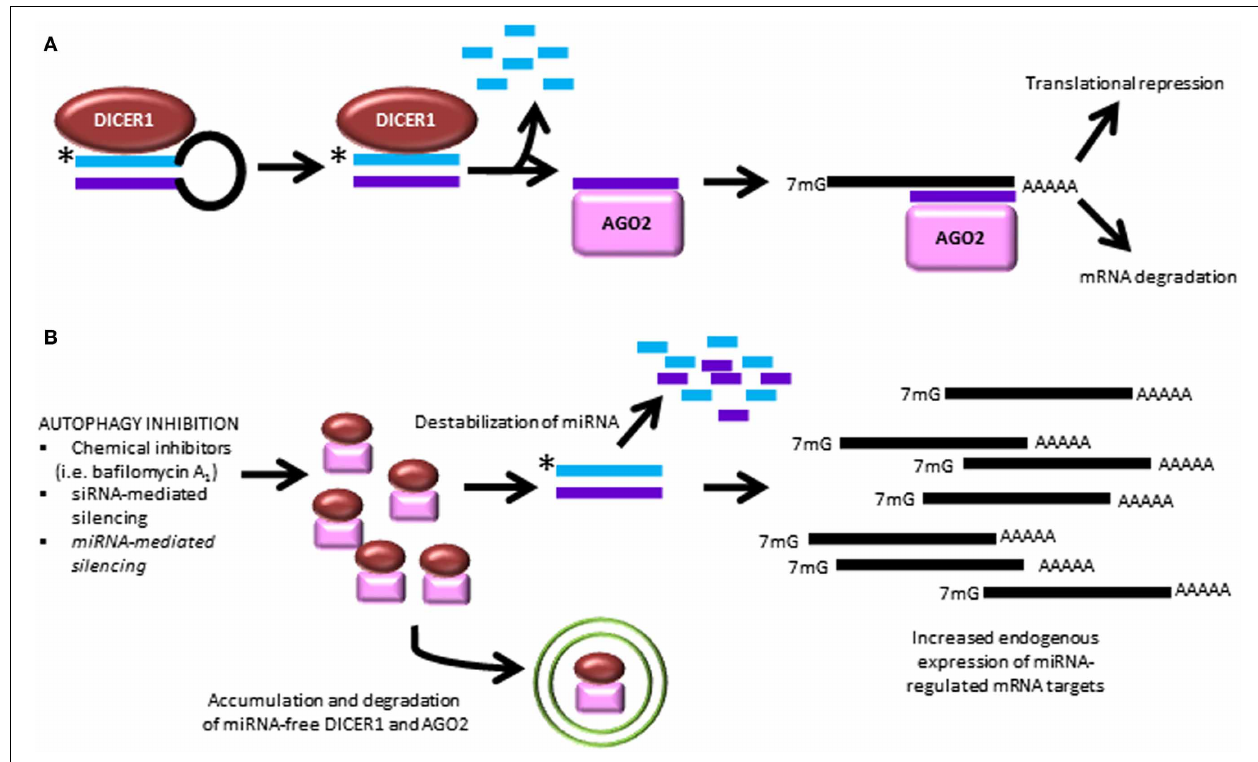
FIGURE 4 | Autophagy inhibition causes dysregulated miRNA processing and function. (A) The canonical pathway of miRNA biogenesis is shown leading to the two best characterized actions of miRNA to cause degradation of mRNA targets and interfere with mRNA translation. (B)